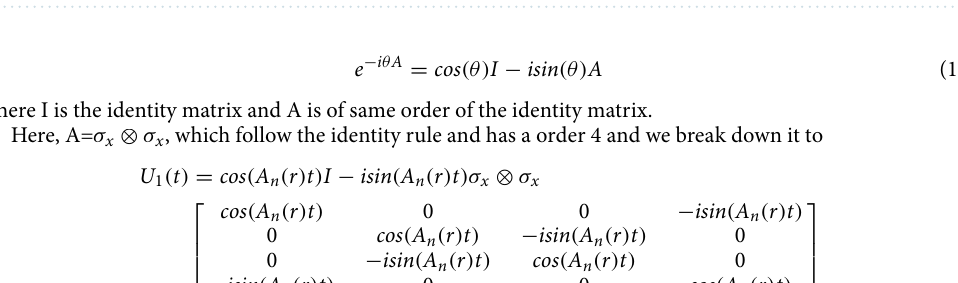
Figure 1. The derived circuit has a combination of a CNOT gate, U3 gate and a CNOT gate, where θ = 2 A n ( r ) t , φ = − π/ 2 and (cid:31) = π/ 2.